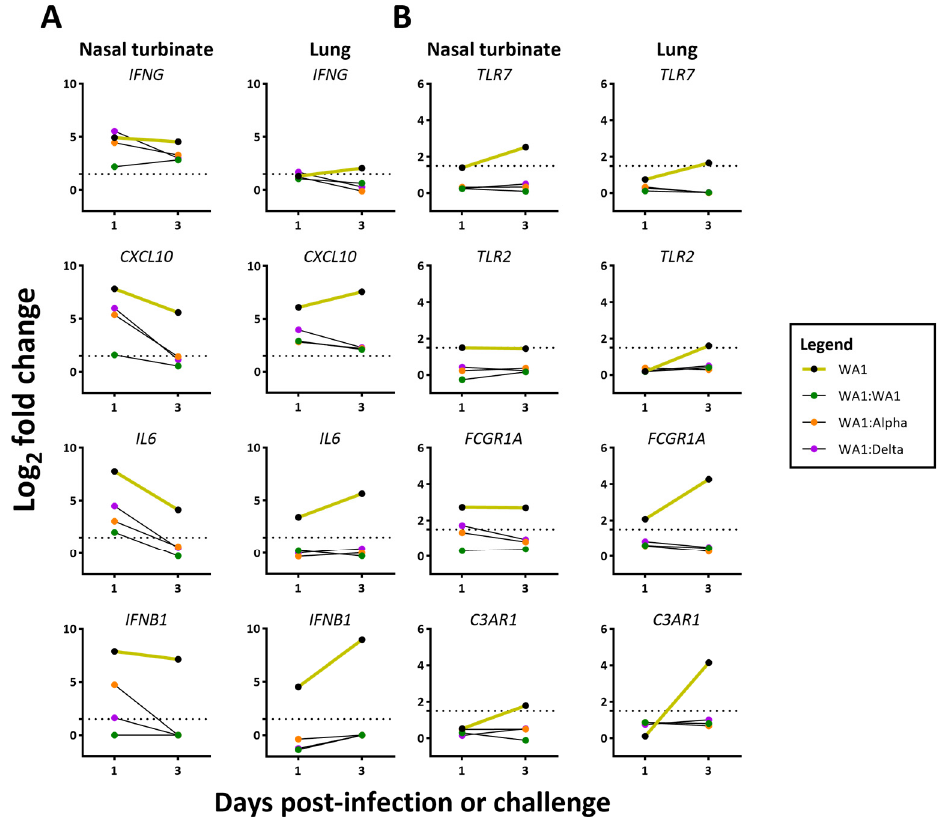
Figure 8. Differential expression of select genes from lung and nasal turbinate samples from WA-1 infected and challenged mice. Graphs comparing log 2 fold change of specific genes in WA1-infected (yellow), WA1:WA1- (green), WA1:Alpha- (red), and WA1:Delta-challenged (purple) groups that are integral to the ( A ) hypercytokinemia–hyperchemokinemia and ( B ) phagosome formation pathways in nasal turbinate and lung samples from 1 and 3 days postinfection from WA1-infected and 1 and 3 days postchallenge for WA1:WA1, WA1:Alpha, and WA1:Delta. As described in the Materials and Methods section, the reads from RNASeq data were mapped to Mus musculus and the SARS-CoV-2, gene counts were assessed in DESeq2. The dotted line indicates a log 2 fold change of 1.5. All genes have a log 2 fold change above 1.5 and an FDR ≤ 0.05, except for NT WA1-TLR2 (0.47), TLR7 (0.25), NT WA1:WA1-IFNG (0.21), CXCL10 (0.27), IL6 (0.33), NT WA1:Alpha-IL6 (0.27), IFNB1 (0.28),